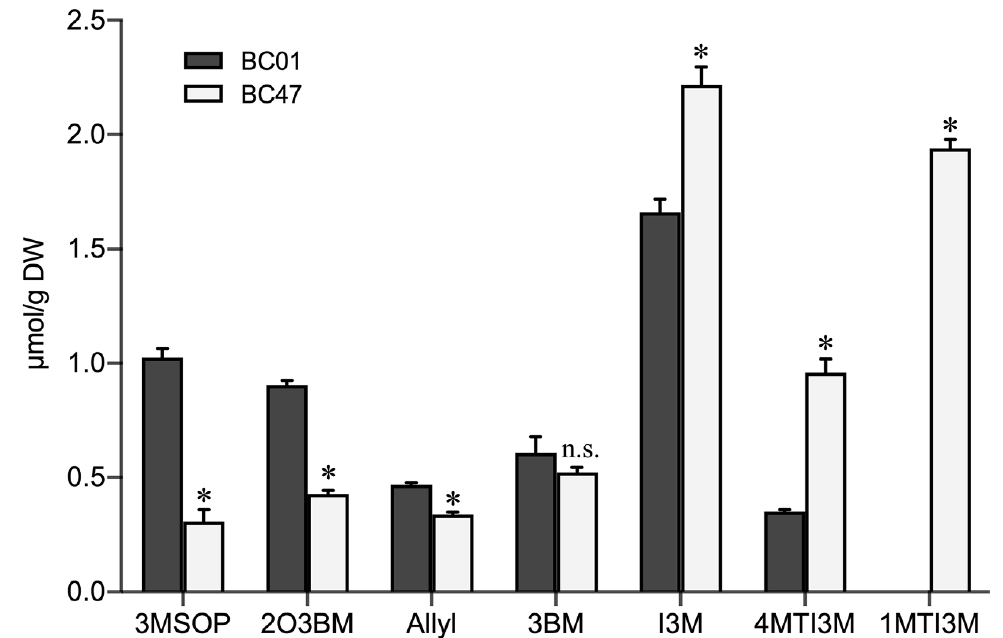
Figure 4. Comparison of glucosinolates compositions and contents in the susceptible and resistant